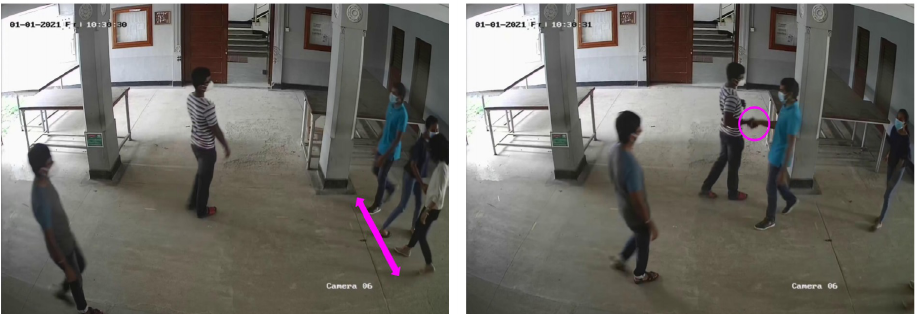
Figure 16. Failure case 3 threat level interpretations. System threat evaluation output—Decreases, Human expert opinion output—Increases.